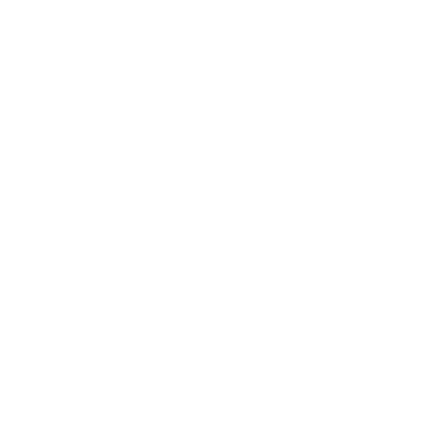
Figure 4. Mean sensory profiles of Pecorino (PE), Passerina (PA), and Trebbiano d’Abruzzo (TR)